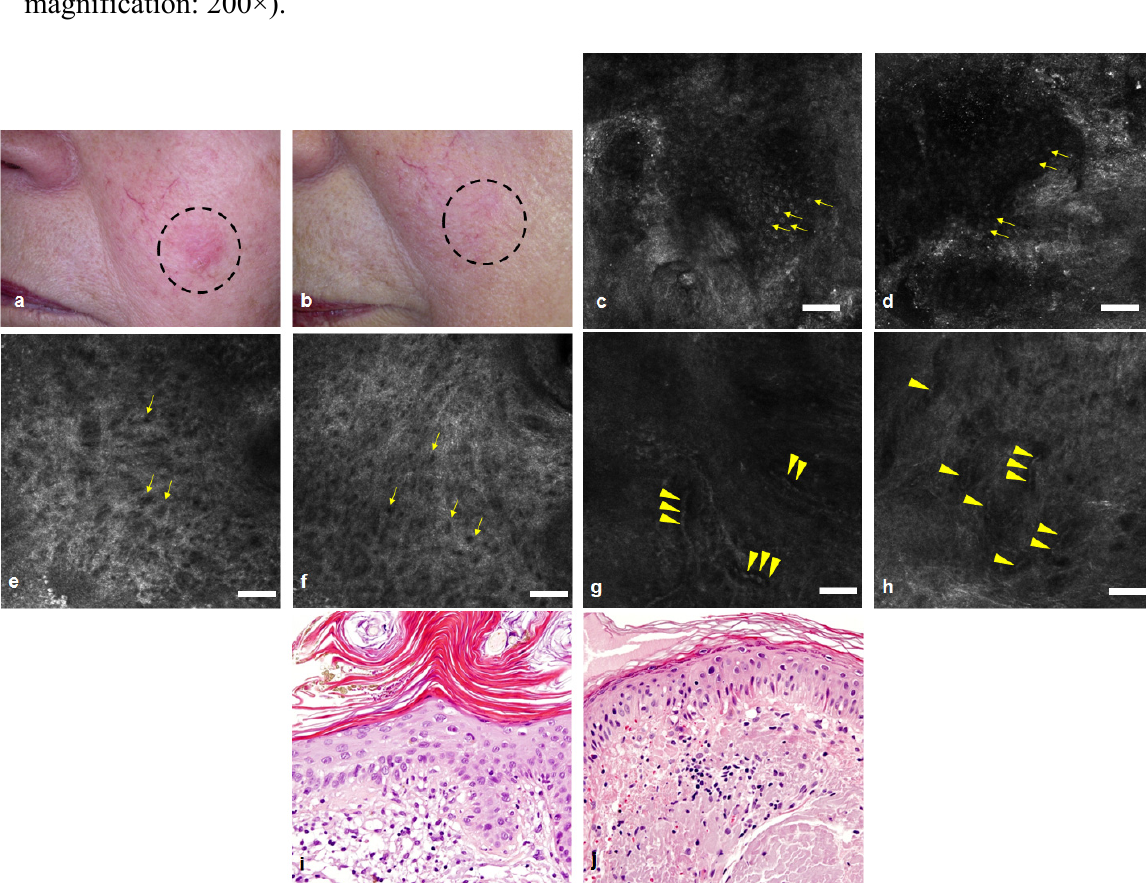
Figure 2. AK before ( a ) and three months after MAL-PDT ( b ): clinical examination shows complete response; In vivo RCM images before MAL-PDT show stratum corneum disruption with individual corneocytes and parakeratosis (arrows) ( c ), architectural disarray with pleomorphism of keratinocytes and loss of cell-to-cell demarcation (arrows) in stratum granulosum/spinosum ( e ) and dilatated blood vessels (arrowheads) containing refractile blood cells in superficial dermal layer ( g ); After MAL-PDT we observed in RCM persistence of all criteria for AK diagnosis in all layers ( d , f , h ) (arrows and arrowheads) (Scale bar: 50 µm). Corresponding histology confirms persistence of all criteria for AK diagnosis before ( i ) and after ( j ) MAL-PDT (Hematoxylin-eosin stain; original magnification: